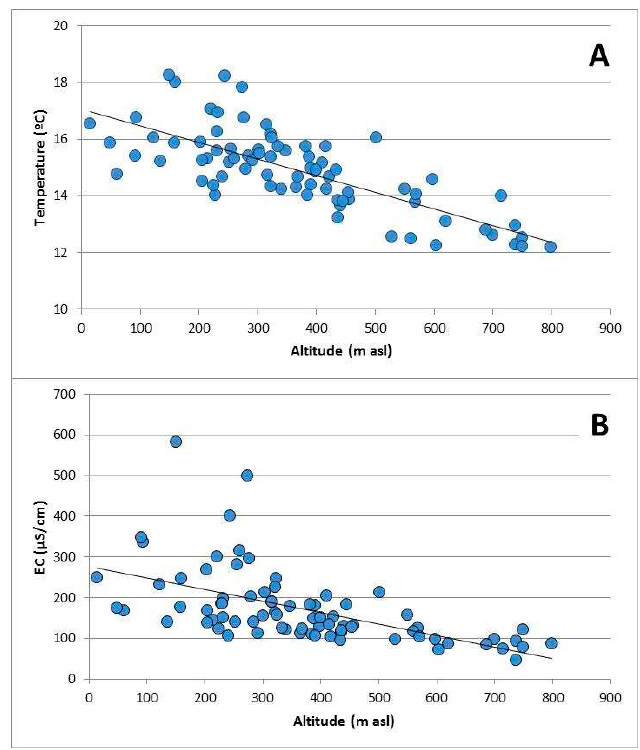
Figure 4. Bivariate plots between ( A ) spring elevation and water temperature (best fit line: y = − 0.0058 + 17.039); and ( B ) spring elevation and water electrical conductivity (best fit line: y = − 0.2849 + 277.3).